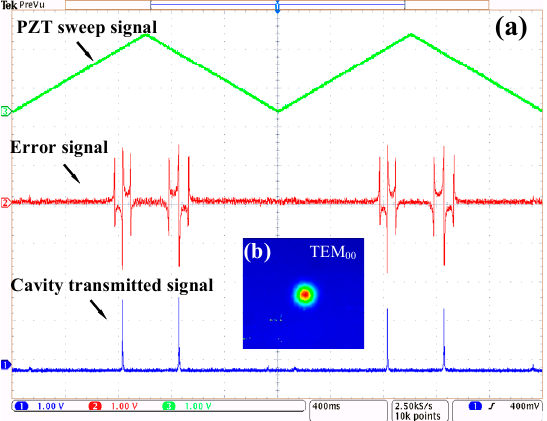
Figure 6. Cavity resonance under critical coupling conditions. ( a ) The green line represents the PZT sweep signal, the red line represents the error signal, and the blue line represents the cavity-transmitted signal. ( b ) Cavity transmission facula.